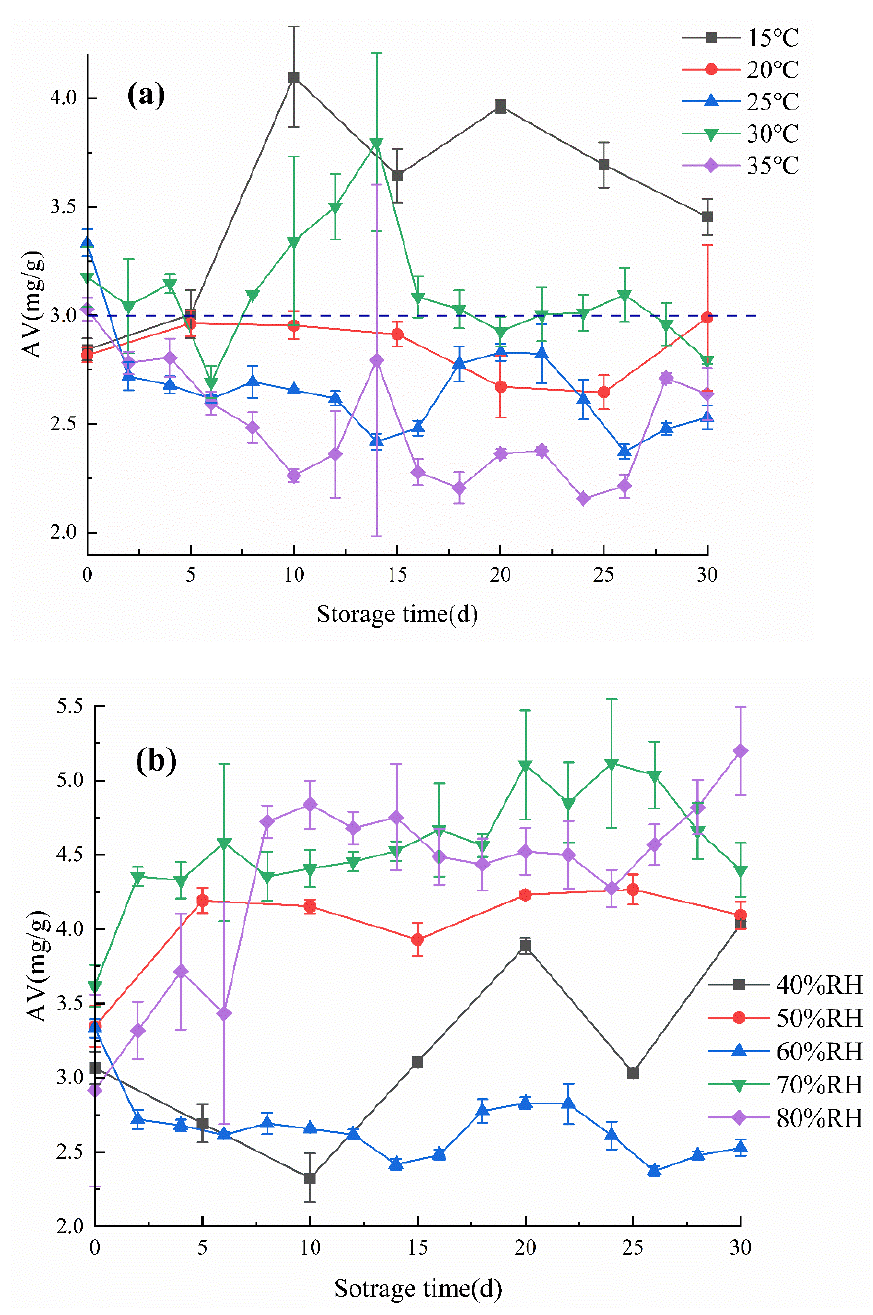
Figure 1. The trend for the AV of fishmeal: ( a ) at 15 ◦ C and 20 ◦ C, 25 ◦ C, 30 ◦ C, and 35 ◦ C; ( b ) at 40% RH, 50% RH, 60% RH, 70% RH, and 80% RH.